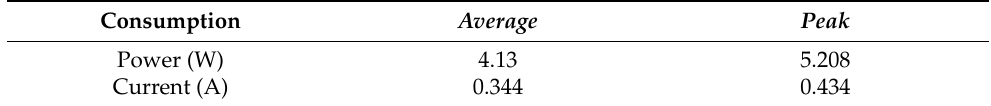
Table 2. Average and peak power and current consumption rates of the camera trap system during low light conditions.